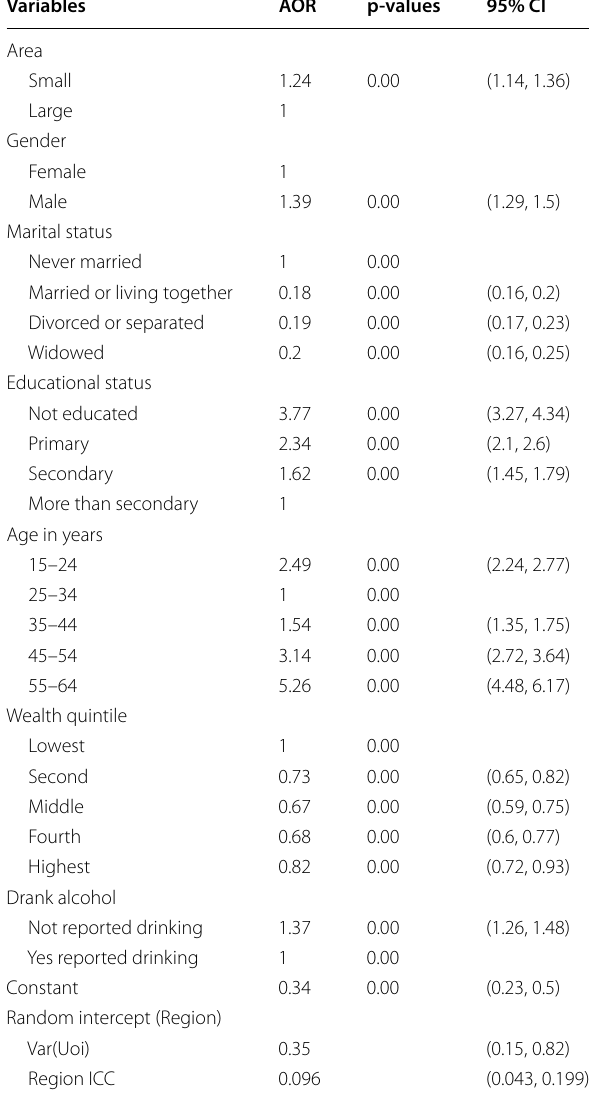
Table 4 Adjusted odds ratio (AOR) and 95% confidence interval (CI) for AOR of the multilevel mixed-effect logistic regression for the associated factors for never tested HIV in urban Ethiopia